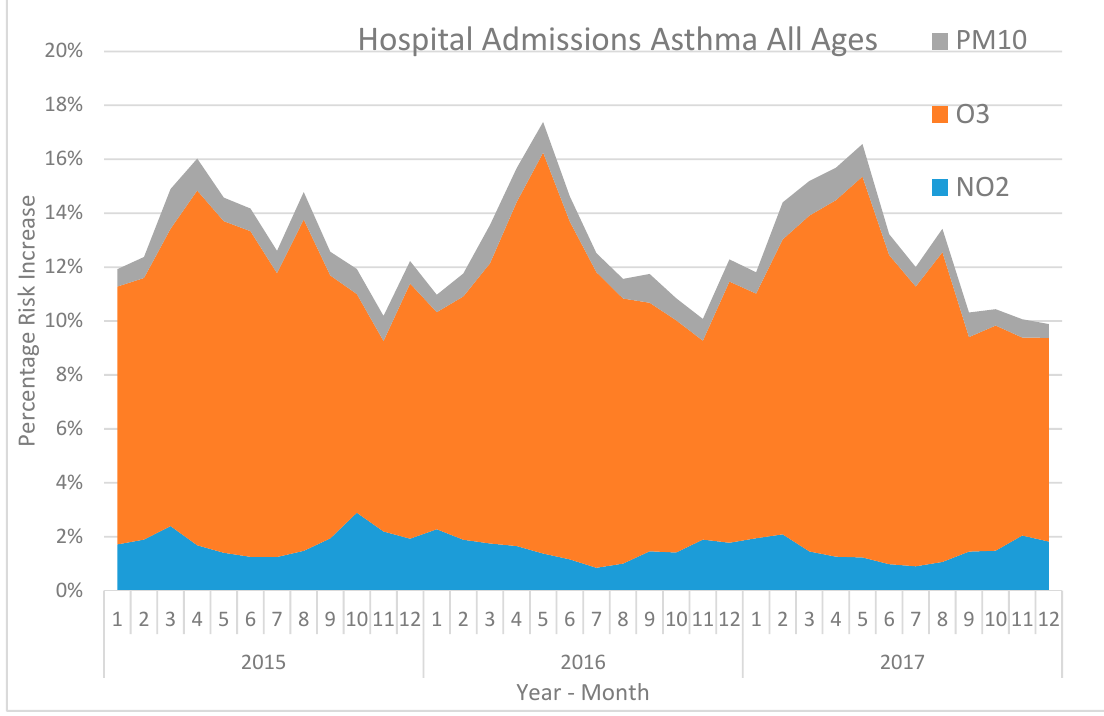
Figure 4. The calculated average monthly percentage risk increase associated with NO 2 , O 3 , and PM 10 for hospital admissions for asthma in all ages in Stockholm during 2015–2017 based on meta- coefficients [8].